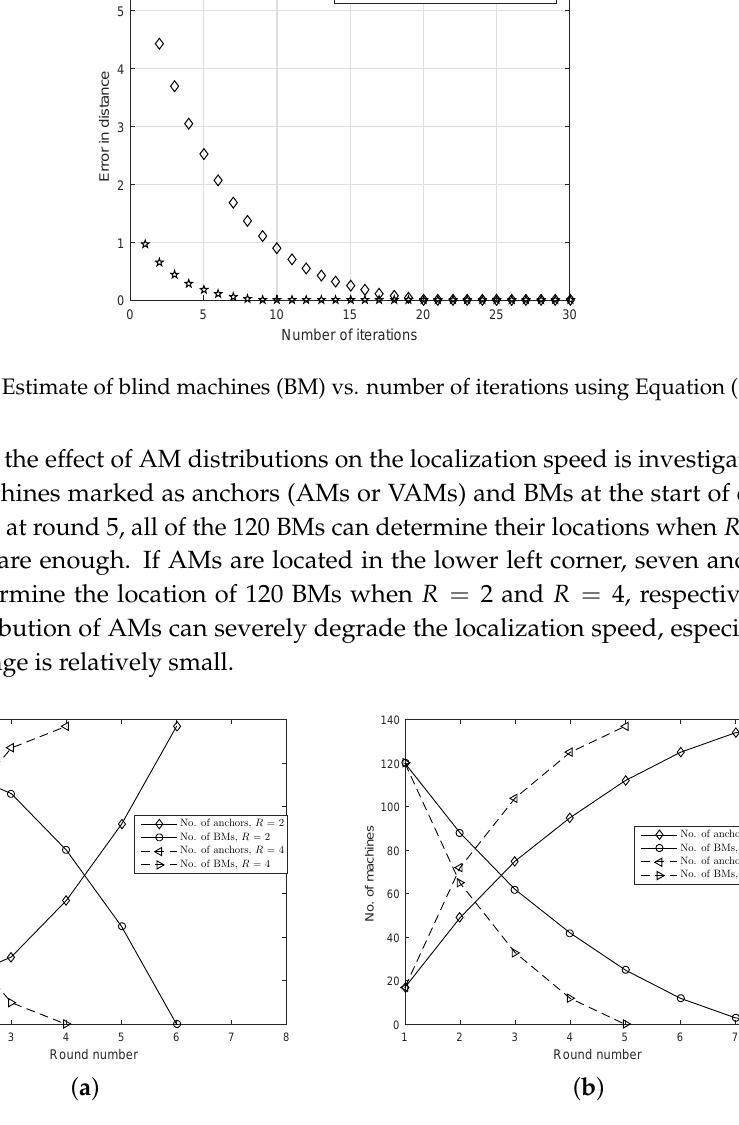
Figure 3. Number of rounds needed to localize the whole machine type communication (MTC) network. ( a ) AMs uniformly distributed over the whole area; ( b ) AMs distributed uniformly in the lower left